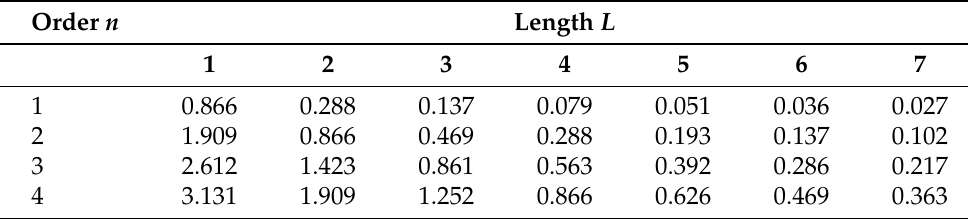
Table 4. Maximum difference between the linear and lowest-order non-linear approximations of the deformation of the buckled clamped beam for several lengths of the beam and for the first four orders of the buckling load. The parameter b is equal to 0.1. The results are multiplied by 100.